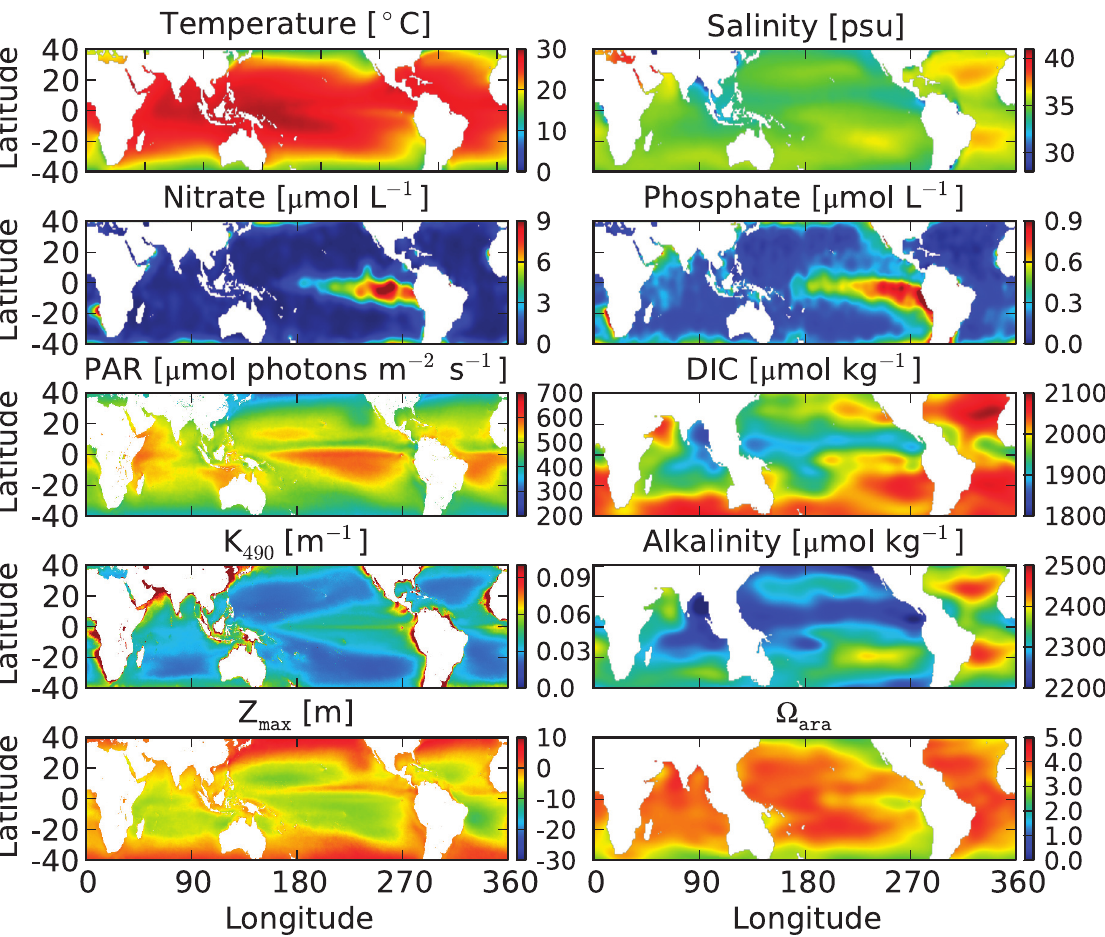
Fig 2. Environmental data used by the ReefHab model. Temperature, salinity, and nutrient data are taken from the World Ocean Atlas (WOA) 2009 and have a 1° × 1° spatial resolution. PAR and K 490 are from SeaWiFS Level 3 data, have a 5 ’ × 5 ’ spatial resolution, and are used to calculate Z max at I min = 450 μ mol photons m -2 s -1 . Alkalinity and DIC are taken from GLODAP, have a 1° × 1° spatial resolution and are used to calculate Ω ara